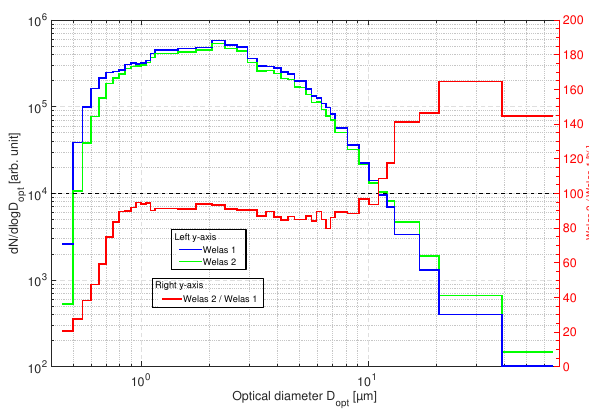
Figure 7. Intercomparison of the ISI WELAS optical particle size spectrometers.